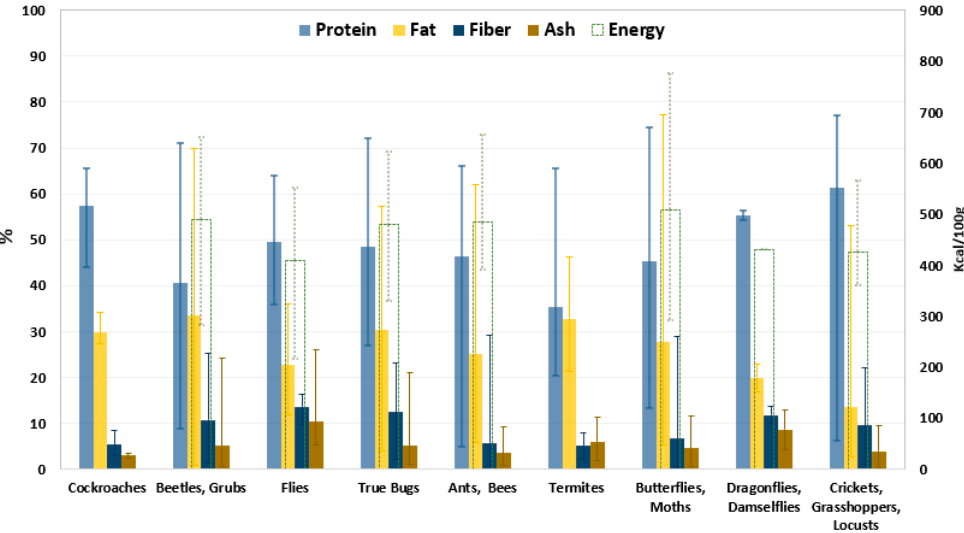
Figure 1. Nutritional composition [%] and energy content [kcal/100 g] of edible insects. Data are reported as average value of dry matter and the error bars indicate the maximum and minimum value determined [6].